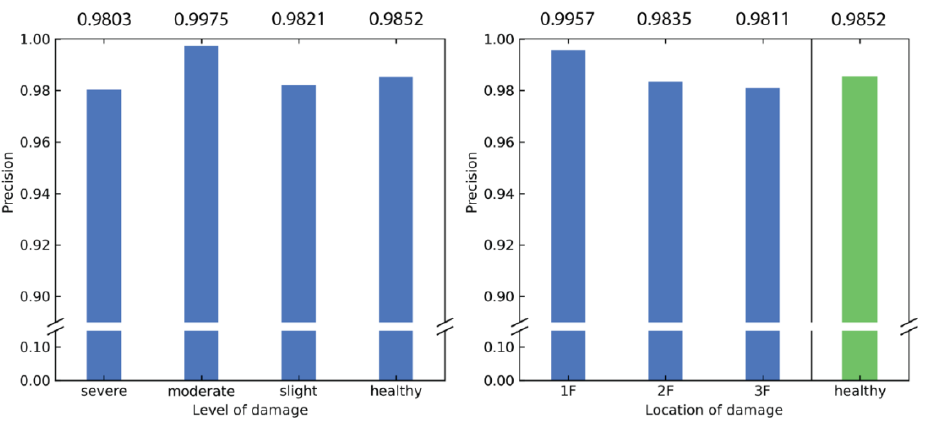
Figure 9. Precision calculated based on level of damage and location of damage.